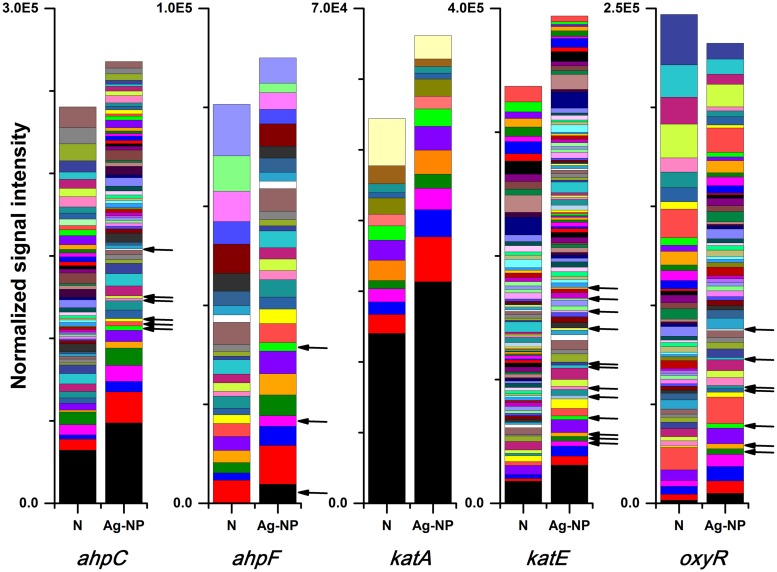
Effects of Ag-NP treatment on genes associated with oxidative stress. N indicates samples with no treatment and Ag-NP indicates samples with Ag-NP treatment. Colors are coded according to the lineage; genes from gene variants present only in Ag-NP treated samples are indicated with black arrows.